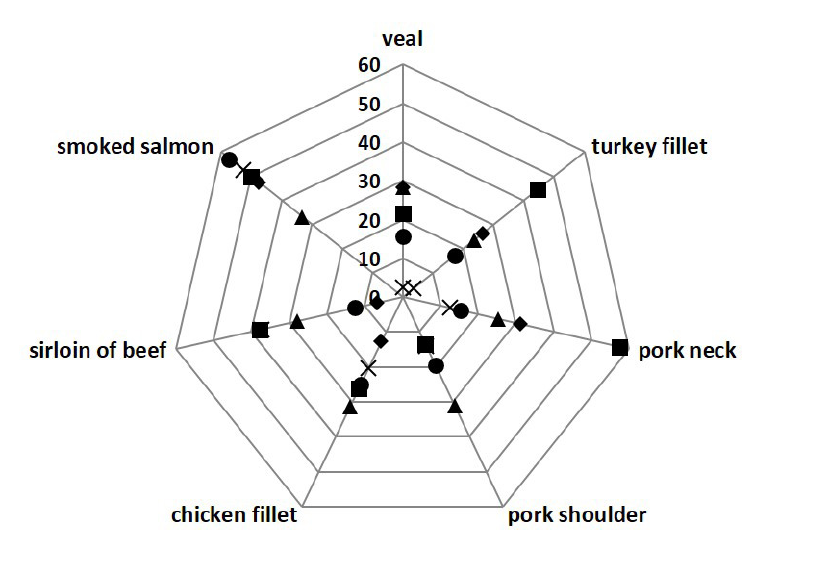
Figure 5: TAP values (GAE) of various meats (500 mg/mL) after extraction using different solvents ( x - methanol, ▲ - water, ■ - buffer pH 2, - hexane, ● - acetone). ♦